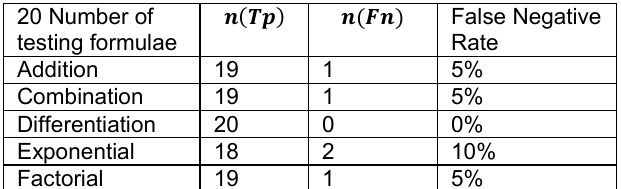
Table 10. The above tabulated value represents overall FNR Measure with Tensorflow from a document of 20